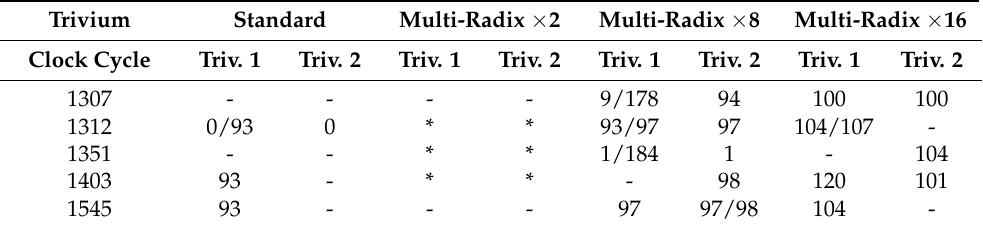
Table 6. Position of the faults injected into each pair of Trivium cipher versions in different clock cycles.